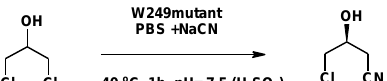
Figure 8. Synthesis of azides from glycerol and carboxylic acids.